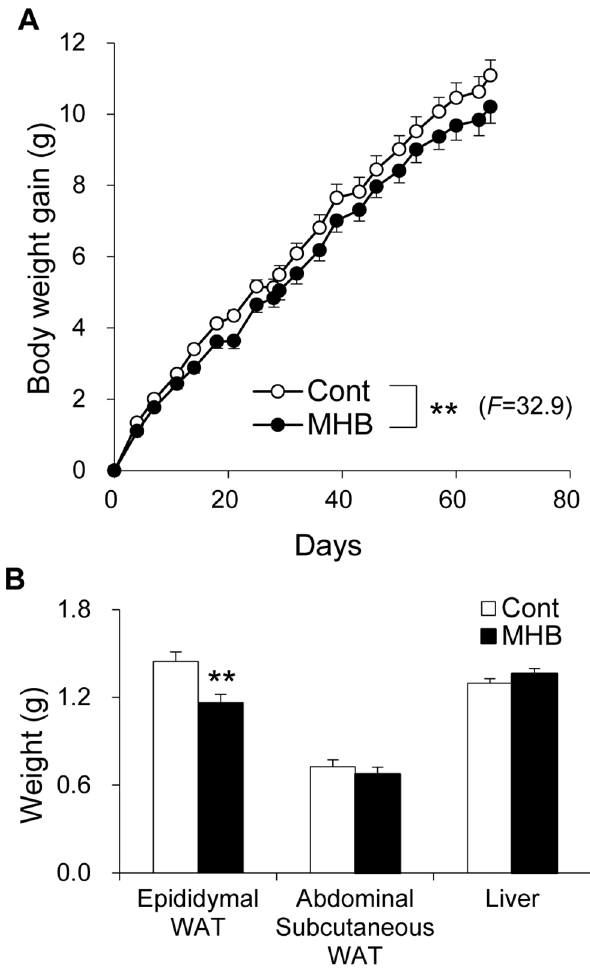
Fig 1. MHB ameliorated HFD-induced body fat accumulation in mice. (A) Body weight gain of HFD-fed mice with or without MHB supplementation. Data are presented as means ± SEM. n = 12 mice/group. ** P < 0.01 (by analysis of variance (ANOVA) with repeated measures). (B) Epididymal WAT, abdominal subcutaneous WAT and liver weight. Data are presented as means ± SEM. n = 12 mice/group. ** P < 0.01 (by unpaired Student ’ s t